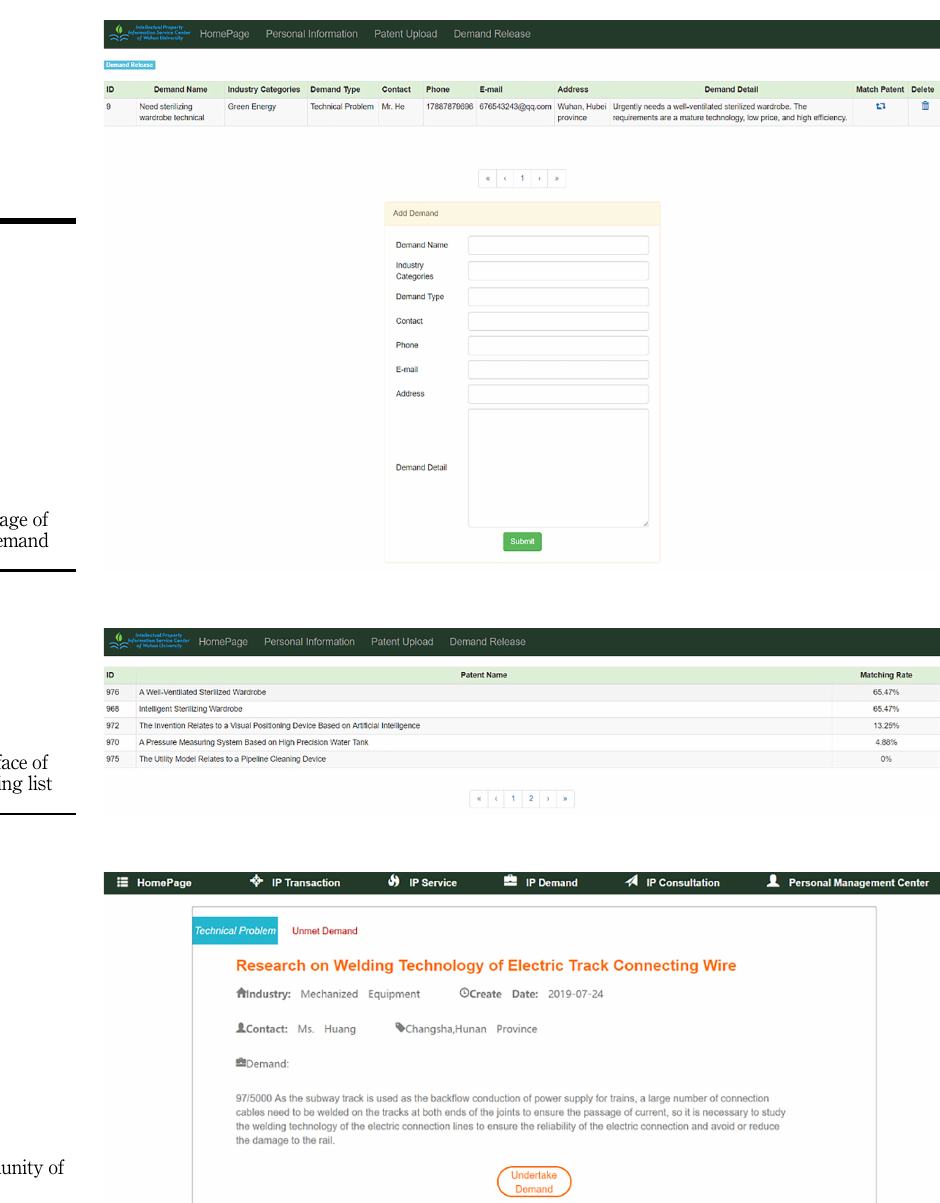
Figure 10. Virtual community of user